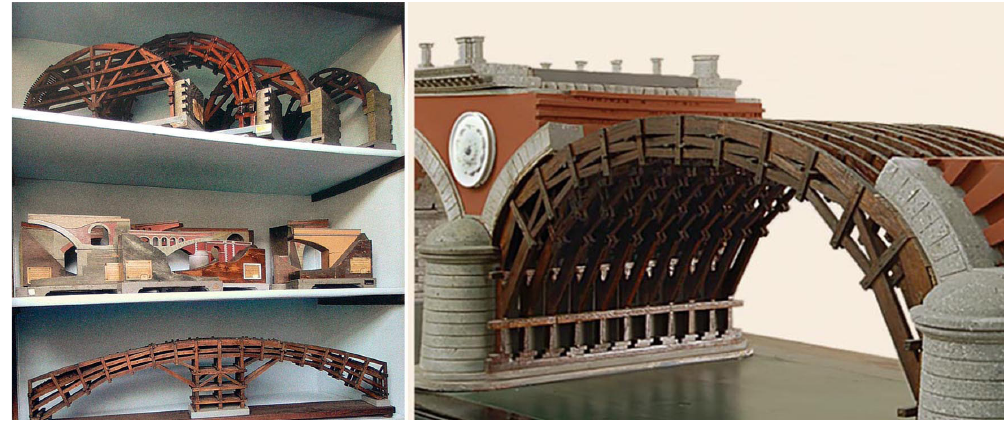
Fig. 5 M. Lo Turco, Models